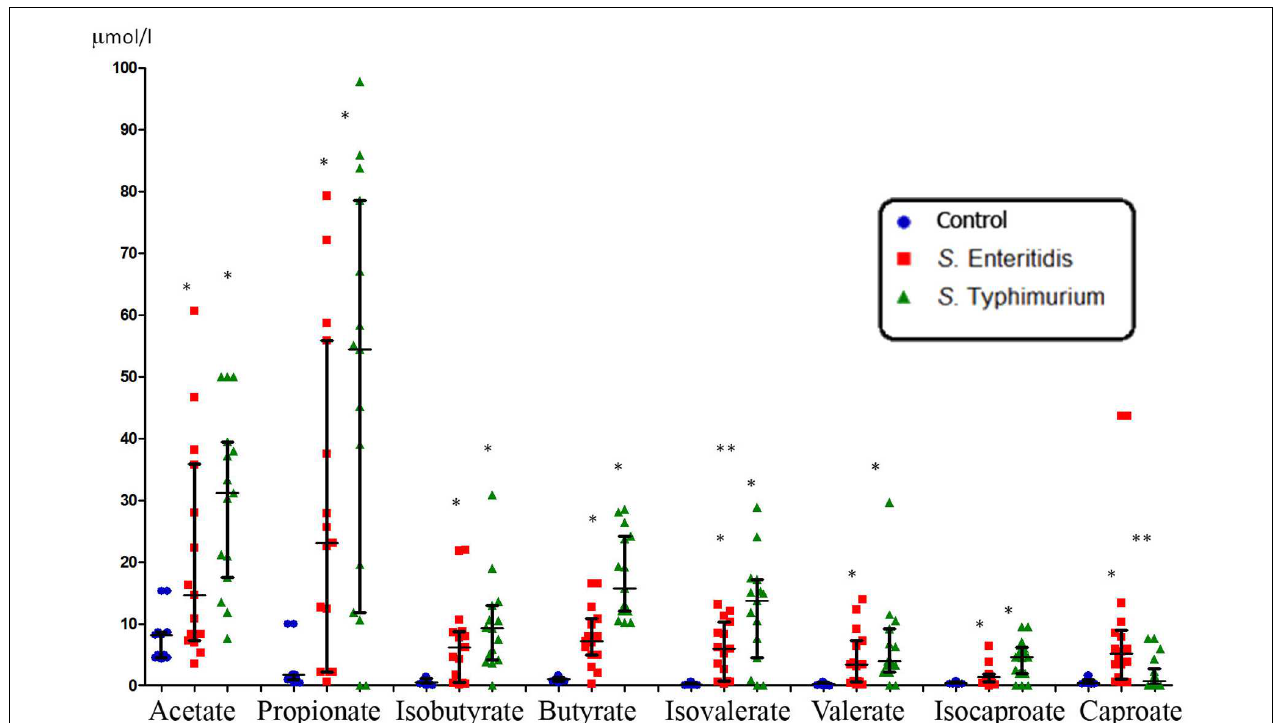
FIGURE 1 | Systemic concentration of SCFAs in patients infected with two serotypes of Salmonella enterica (median with interquartile range). Statistically significant differences in SCFA concentrations: ∗ significant difference between infected and control subjects ( p ≤ 0.05, Mann–Whitney U -test) and ∗∗ significant difference between S . Enteritidis- and S . Typhimurium-infected patients ( p ≤ 0.05, Mann–Whitney U